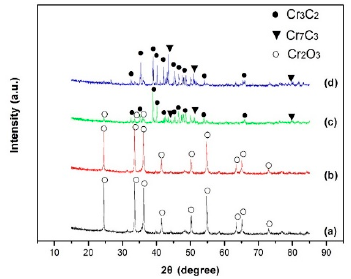
Figure 1. XRD patterns of the powders before and after microwave heating: ( a ) before microwave heating (32 wt% C); ( b ) before microwave heating (34 wt% C); ( c ) 1000 °C, 1 h (32 wt% C); ( d ) 1000 °C, 1 h (34 wt% C).